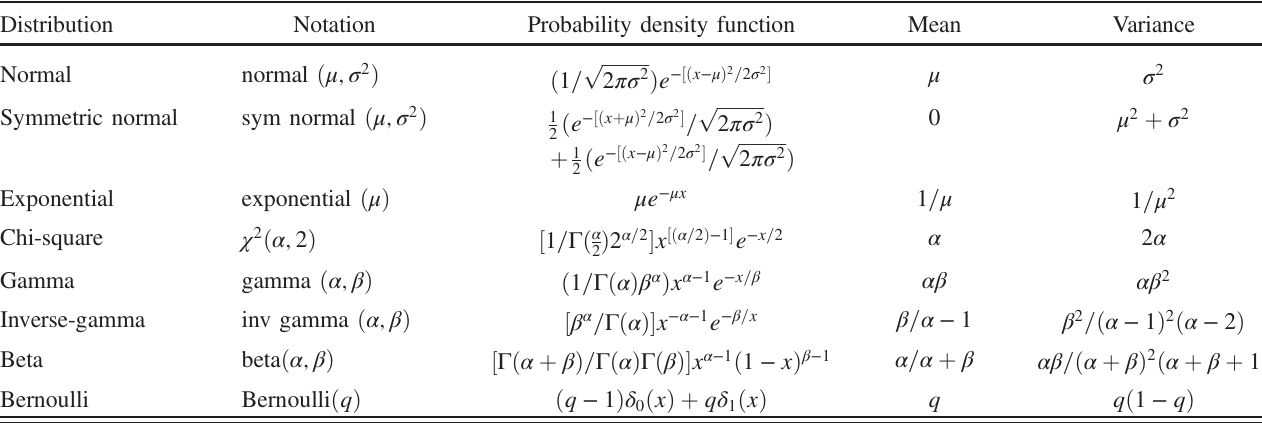
TABLE III. Probability distributions used and their densities. Here, the corresponding random variables are denoted by x . We use “ ; ” to separate random variables from parameters. For example, normal ð x ; μ ; σ 2 Þ means that x is the random variable [e.g., R þ ∞